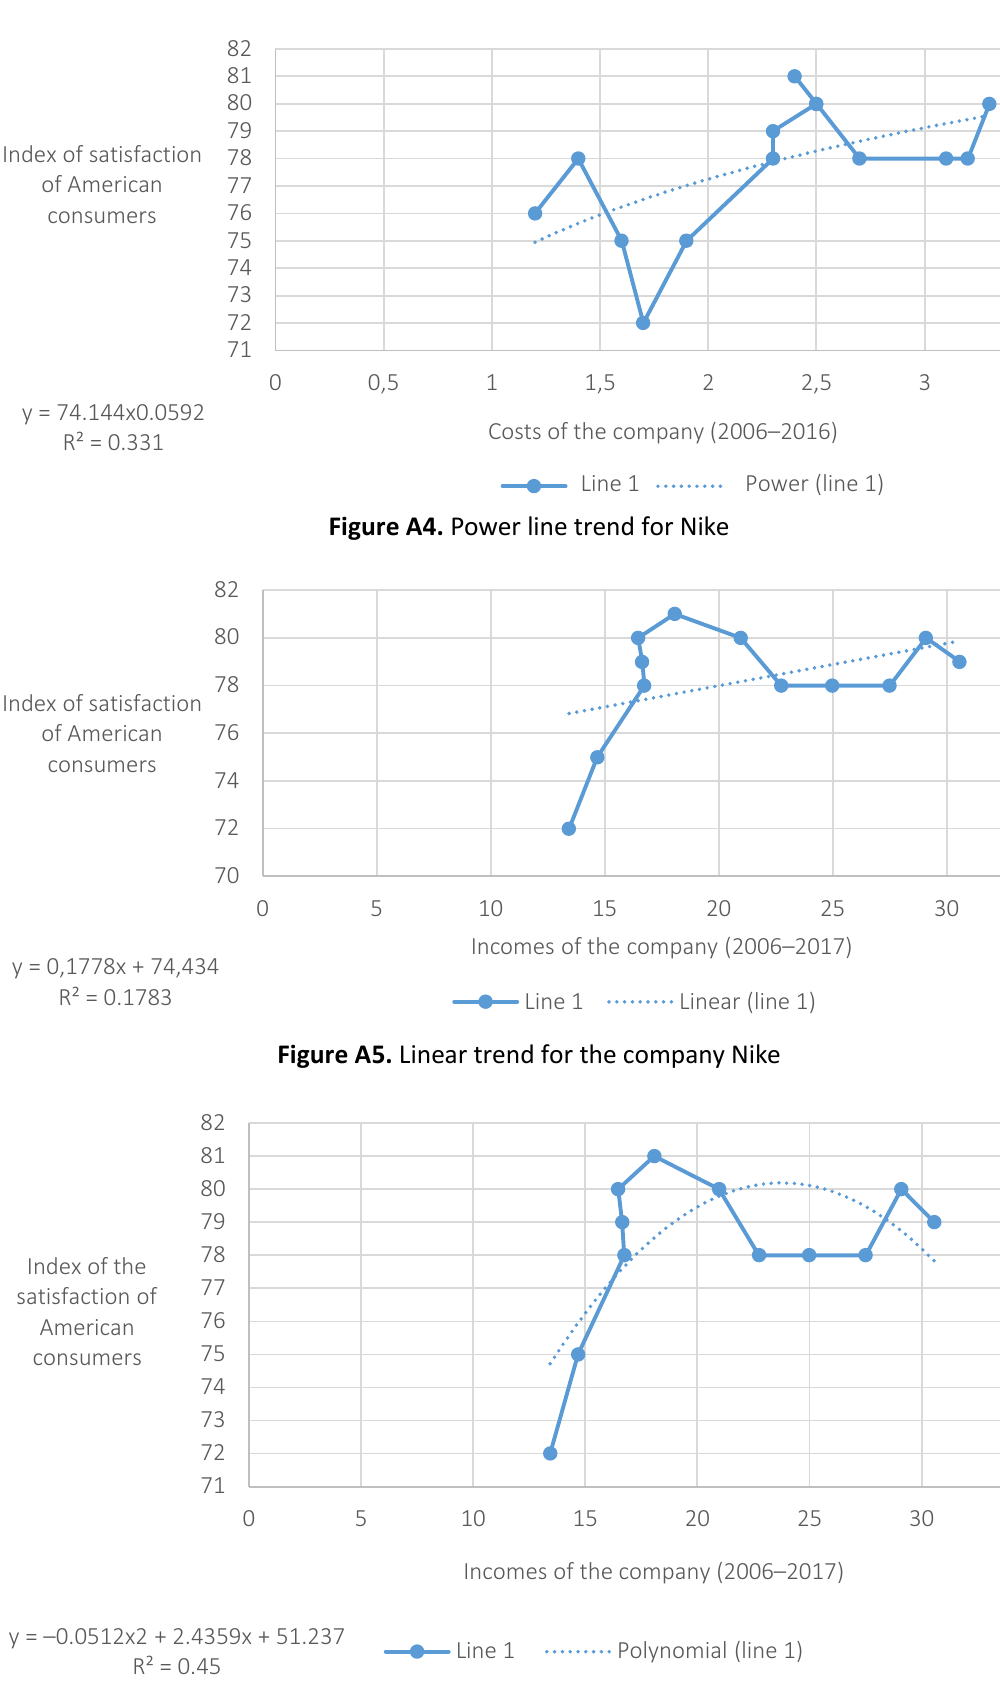
Figure A6. Polynomial trend for the company Nike